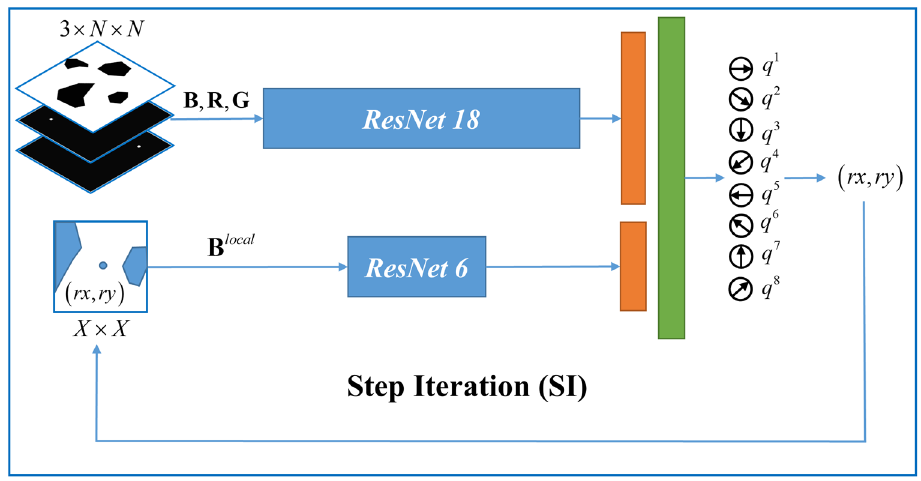
Figure 3. The SP-ResNet planner.